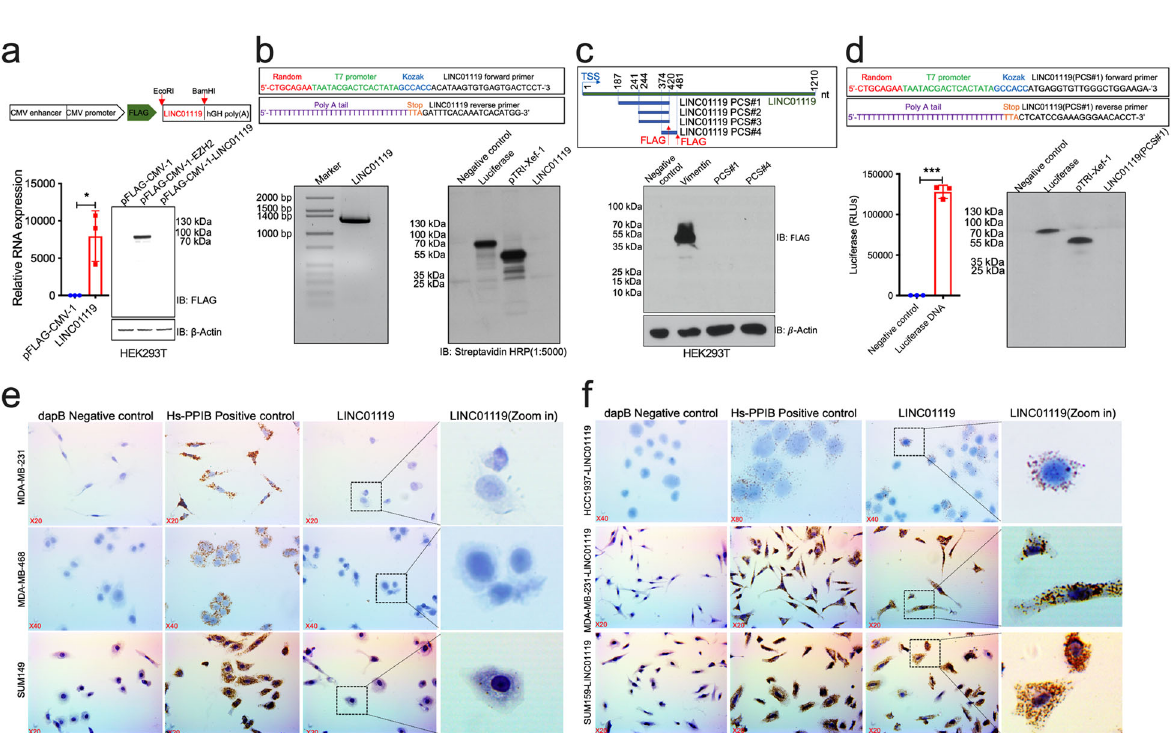
Fig. 4 LINC01119 is a bona fi de non-coding RNA located in the cellular cytoplasm. a Upper: schema of LINC01119 plasmid template for in- cell transcription/translation. Bottom: qRTPCR (mean ± SD of n = 3) (left) and Western blot (right) of RNA and lysates derived from HEK293T cells transiently transfected with LINC01119 or indicated controls. b Upper: schema of 5 ’ and 3 ’ LINC01119 primers utilized in in vitro transcription reactions. Bottom Left: in vitro transcribed LINC01119. Bottom Right: SDS-PAGE on in vitro translated luciferase, pTRI-Xef-1, and LINC01119. c Upper: schema of LINC01119 putative coding sequences. Bottom: Western blot analysis of lysates of HEK293T cells transiently transfected with empty pFLAG-CMV-1, pFLAG-CMV-1-Vimentin, PCS#1 and #4. d Upper: schema of 5 ’ and 3 ’ LINC01119 PCS#1 with primers utilized in in vitro transcription reactions. Bottom Left: Luciferase activity (mean ± SD of n = 3) of the successfully transcribed and translated luciferase used as a positive control for transcription. Bottom Right: SDS-PAGE on in vitro translated luciferase, pTRI-Xef-1, and LINC01119 PCS#1. e , f Localization of LINC01119 in control MDA-MB-231, MDA-MB-468, and SUM149 cells ( e ) and in HCC1937, MDA-MB-231 and SUM159 cells stably over-expressing LINC01119 ( f ) determined by RNAscope; dapB and Hs-PPIB served as negative and positive controls, respectively. Images shown are representatives of n >